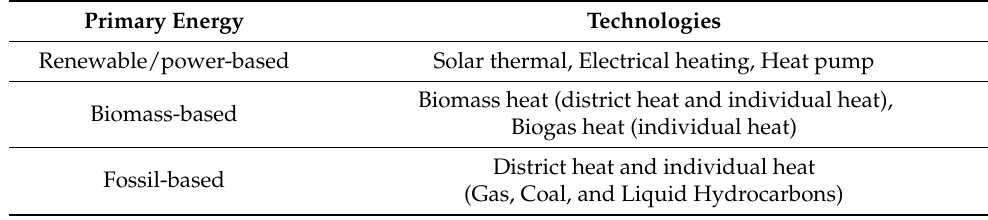
Table 3. Heat generation technologies (adapted from